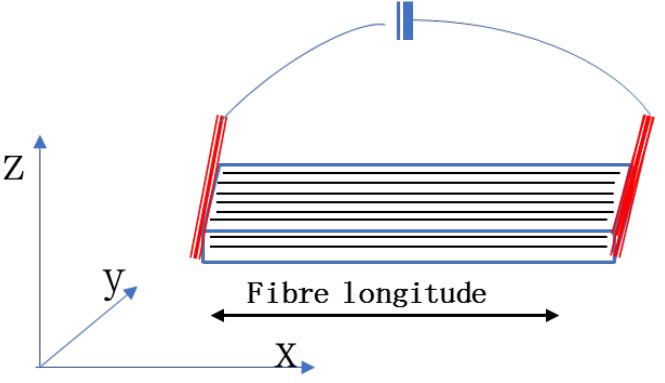
Figure 2. The circuit for the electric response of the CFRE composite plate. Figure 2. the circuit for the electric response of the CFRE composite plate. Figure 2. the circuit for the electric response of the CFRE composite plate. According to the HB 7401-1996 standard [31], CFRE composite plates are subjected to hygroscopic treatment. Specifically, 20 mm × 10 mm × 2 mm CFRE plates were immersed in deionized water within a plastic box and placed in an oven (LVO-0B(6020), Shanghai Longyue instrument equipment Co., Ltd., Shanghai, China) (Figure 3a), and the chamber temperature was set at 70 ◦ C. During this test, the sample was taken out for a certain period of time (up to 9 days) and weighed with a highly precise electric balance (BT25S, Sartorius Scientific Instrument (Beijing) Co., Ltd., Beijing, China) (Figure 3b) after removing its surface adsorbed water with a paper tissue. Such a test was repeated at least three times to obtain the reliable hygroscopic behavior of the composite